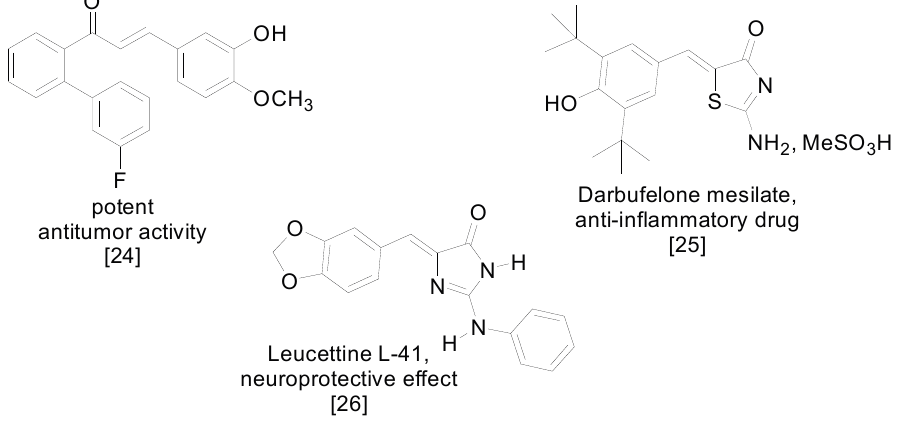
Figure 1. Selected molecules with high biological